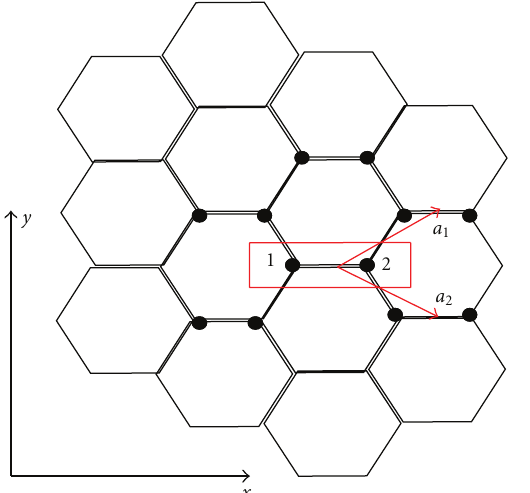
Figure 4: Vectors definition of graphene for converting to a carbon